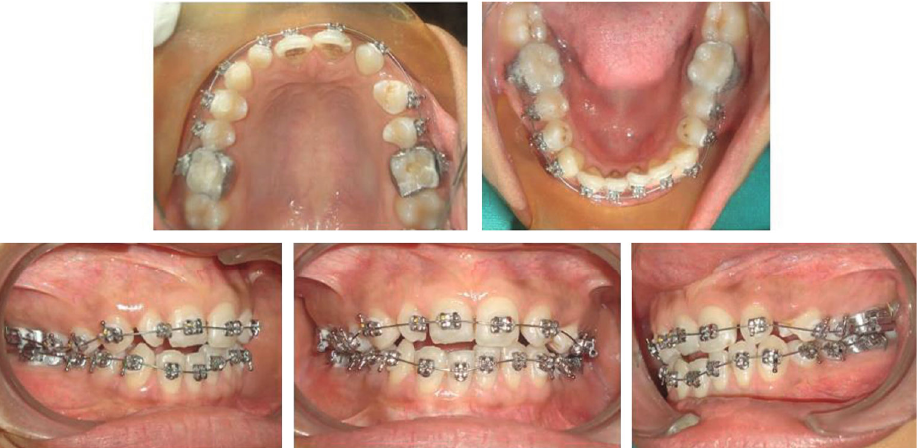
Figure 4: Midtreatment photographs.